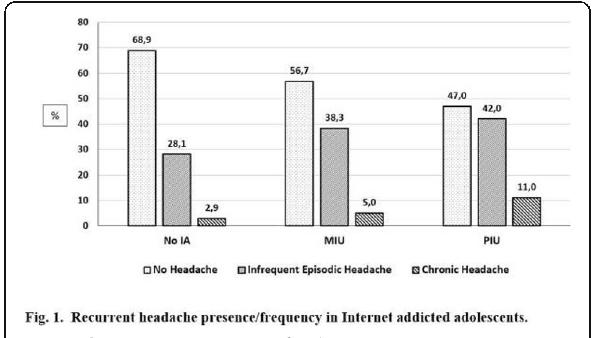
Fig. 1 (abstract P046). See text for